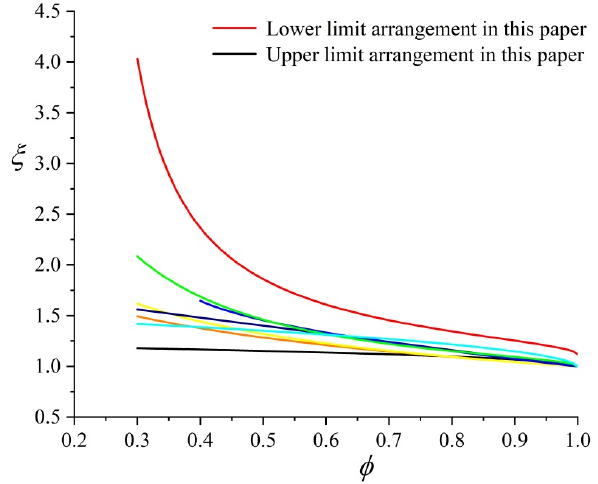
Figure 6. Comparison of the tortuosity model in this paper with other models